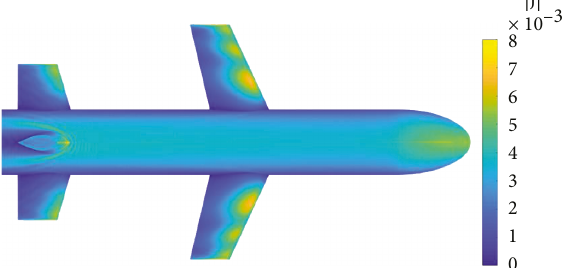
Figure 11: Parallel performance tests with respect to strong scalability. N : number of cores.